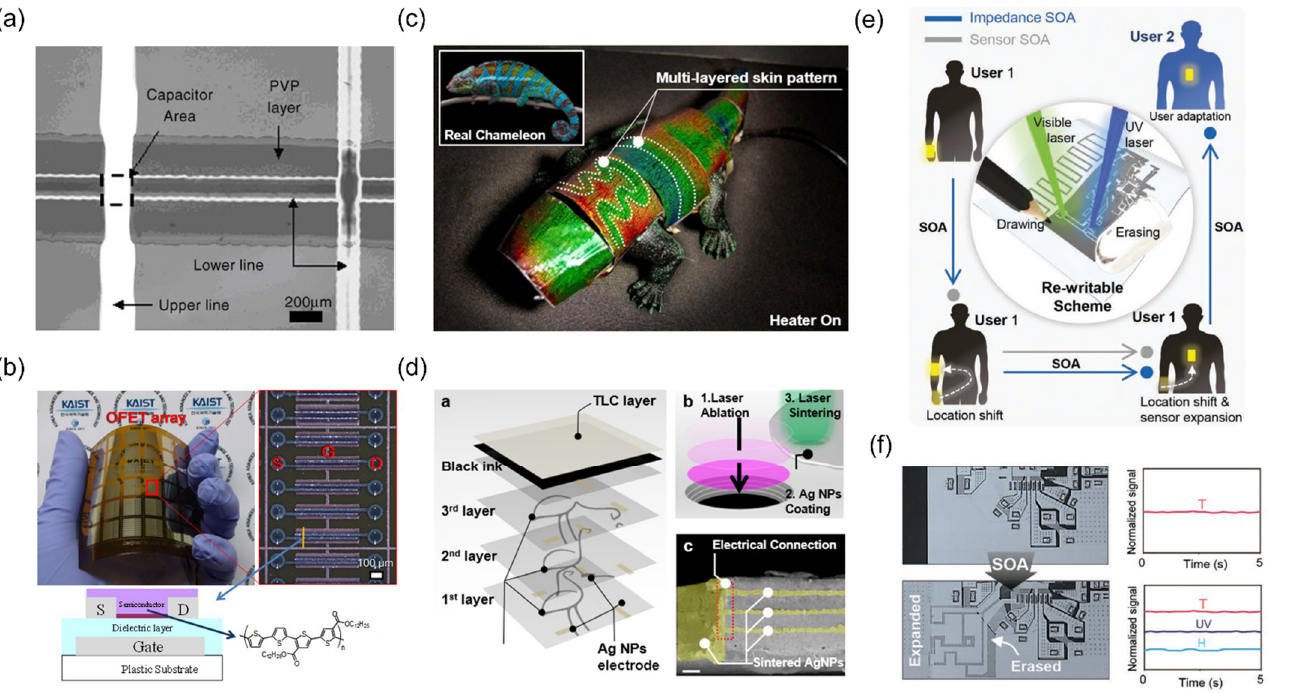
Figure 3. ( a ) Crossover capacitor created by inkjet-assisted laser sintering. Reprinted with permission from Ref. [76]. 2007 Elsevier, Amsterdam, The Netherlands; ( b ) OFET array on PI substrate together with high manification image. (below: cross-sectional structure of a single OFET) Reprinted with permission from Ref. [28]. ( c ) Biomimetic chameleon robot with ( d ) Ag NW and TLC-based Artificial Chameleon Skin. (ATACS) Note that the electrical connections are enabled by the selective laser sintering of Ag NPs, aided by laser ablation of via holes. Reprinted with permission from Ref. [103]. ( e ) Concept of evolvable skin electronics that enables in situ and in operando adaptation (SOA) by re-writable laser processing. ( f ) Addition of UV and humidity sensing capabilities by SOA. Reprinted with permission from Ref [104]. 2022 Wiley-VCH Verlag GmbH & Co. KGaA, Weinheim, Germany.